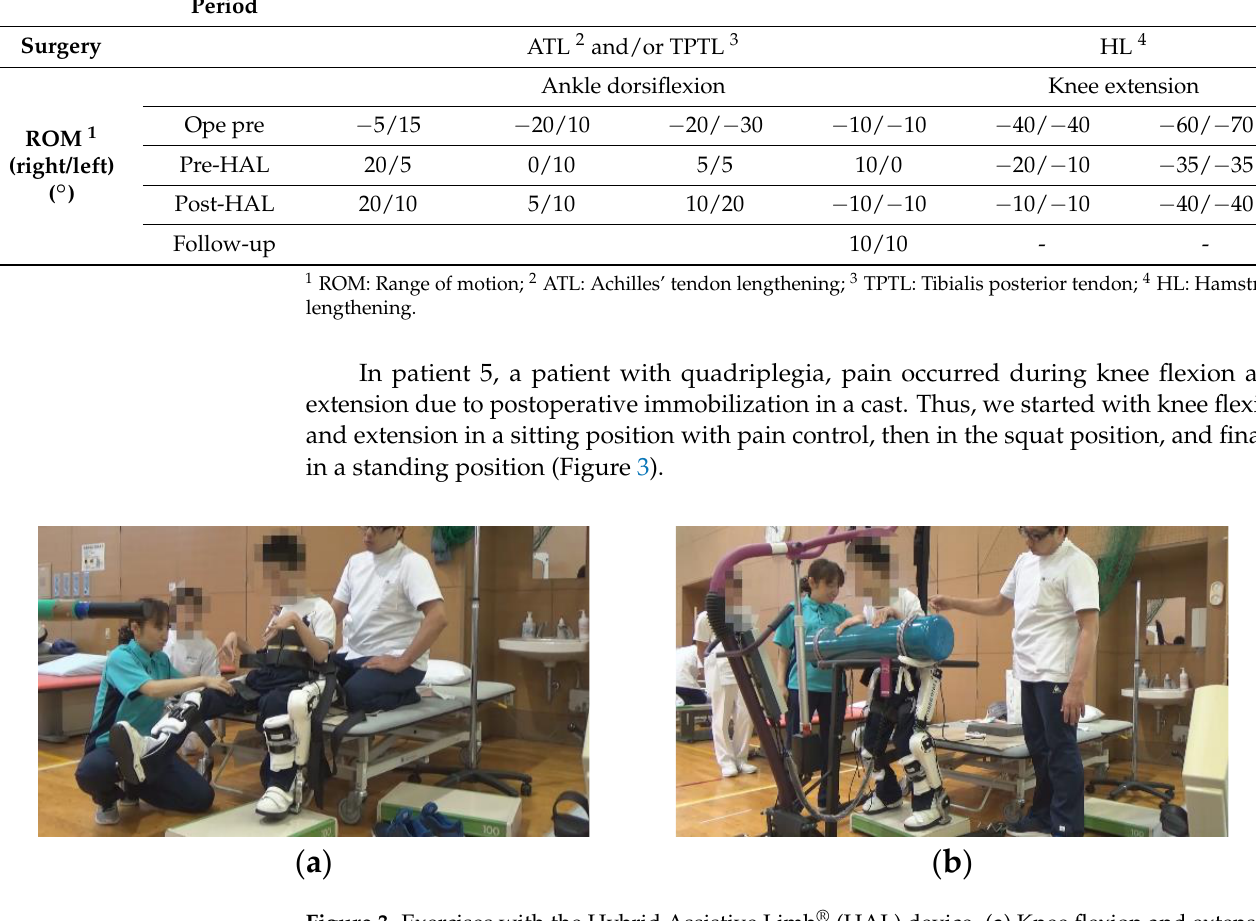
Figure 3. Exercises with the Hybrid Assistive Limb ® (HAL) device. ( a ) Knee flexion and extension exercise in a sitting position with the Hybrid Assistive Limb ® (HAL). ( b ) Squat exercise in a standing position with HAL.